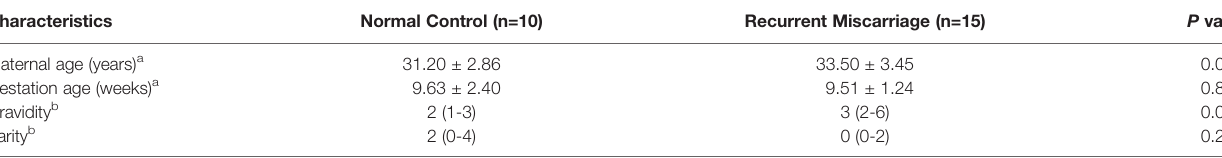
TABLE 1 | Demographic and clinical characteristics of the study population.